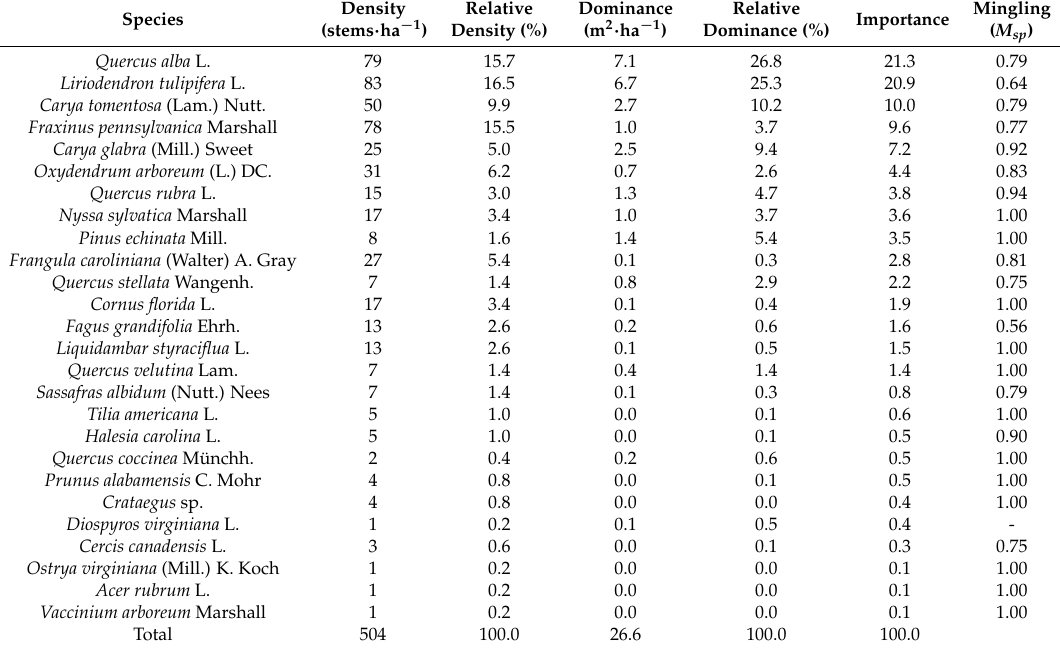
Table 1. Density (stems · ha − 1 ), relative density, dominance (basal area, m 2 · ha − 1 ), relative dominance, relative importance (mean of relative density and relative dominance), and mingling index for trees (live stems ≥ 5 cm dbh) documented in a multi-cohort forest on the Oakmulgee Ranger District of the Talladega National Forest, Alabama. Species are ranked by importance. dbh, diameter at breast height. Density Relative Dominance Relative Mingling Species Importance (stems · ha − 1 ) Density (%) (m 2 · ha − 1 ) Dominance (%) ( M sp ) Quercus alba